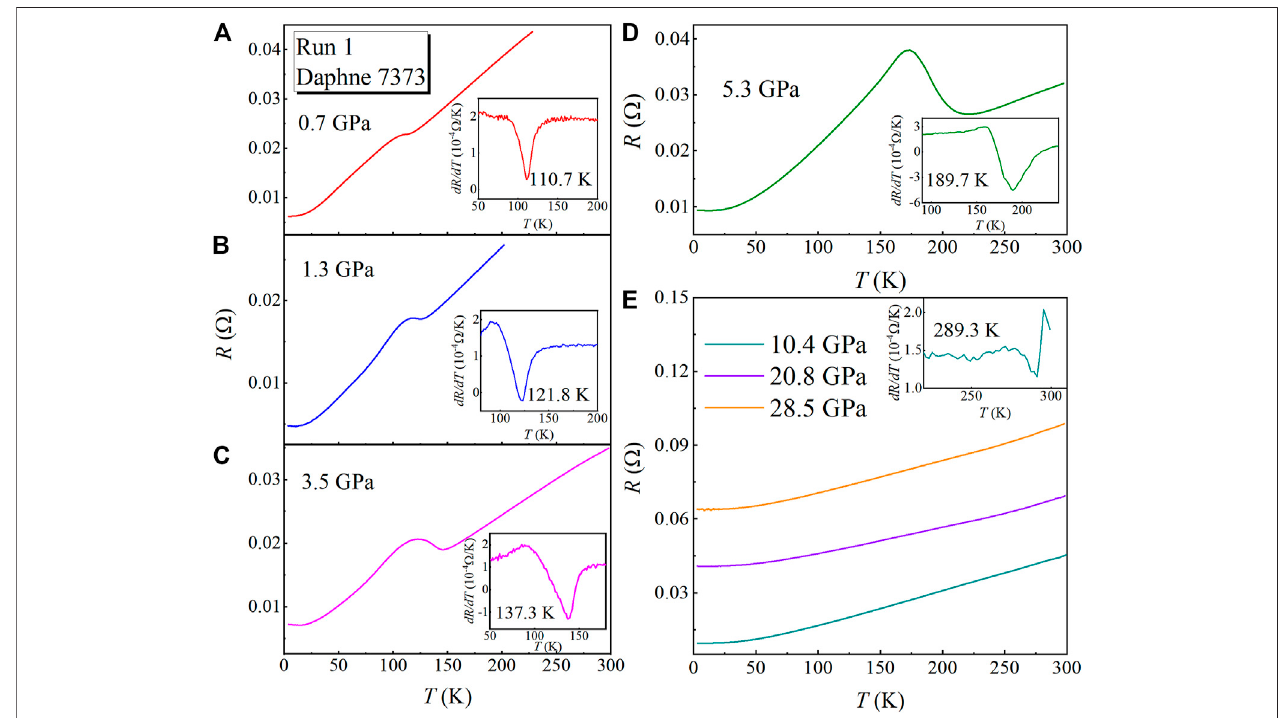
FIGURE 2 | High-pressure resistance measurements were performed using Daphne 7373 as the pressure medium (Run 1). (A) – (E) Temperature dependence of resistance of 1 T -VSe 2 at various pressures. Insets of (A) – (E) : Temperature dependence of d R /d T .